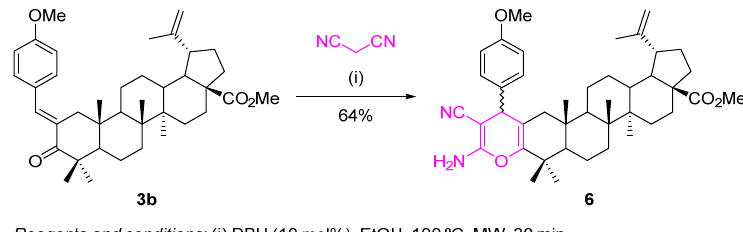
Scheme 4. Proposed tandem reaction pathway for the formation of 1,2-oxazine-fused BoOMe com-